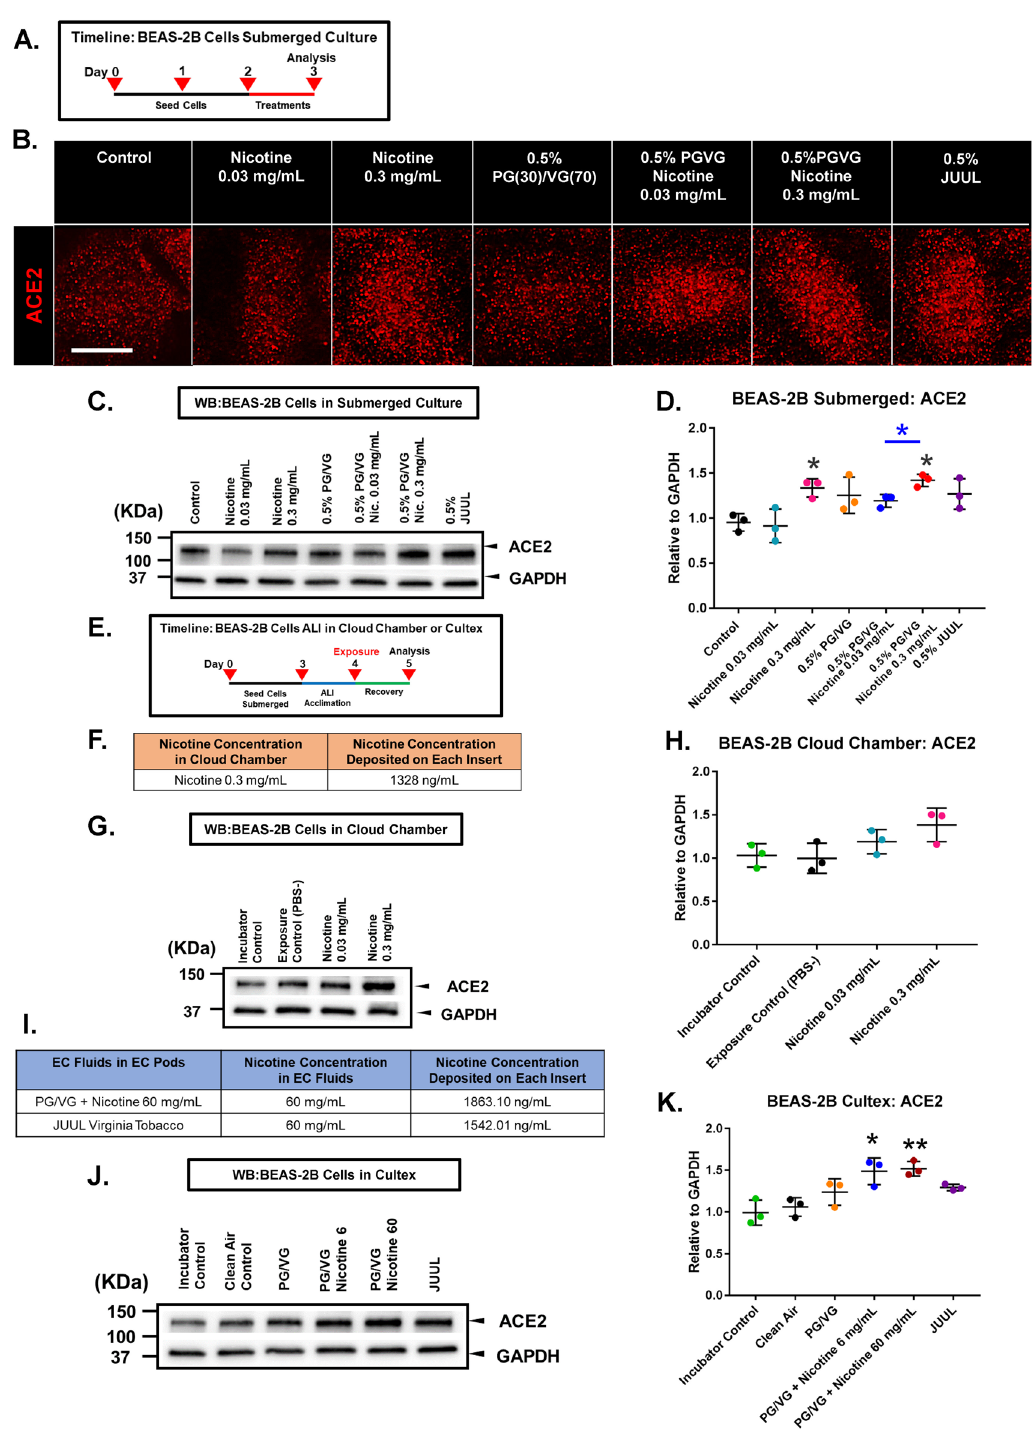
Figure 1. ACE2 expression in BEAS-2B cells during exposure in submerged culture and at the air–liquid interface. ( A ) Experimental treatment used in submerged culture. ( B ) Micrographs showing cells labeled with ACE2 antibody. Scale bar = 15 µm. ( C–D ) The effect of JUUL e-liquid, nicotine, and PG/VG on ACE2 during submerged culture (Western blot). ( E ) Experimental treatment used with cells exposed at the ALI in a cloud chamber or the Cultex system. ( F ) Concentration of nicotine deposited in each well following aerosolization of 0.3 mg/mL of nicotine in a cloud chamber. ( G – H ) The effect of 1 puff of nicotine-containing aerosol on ACE2 following ALI exposure in a cloud chamber (Western blot). ( I ) Nicotine concentration in each well following exposure to aerosol generated from PG/VG/nicotine 60 mg/mL or JUUL “Virginia Tobacco” in a Cultex system. ( J – K ) The effect of 10 puffs of nicotine- containing EC aerosols on ACE2 following ALI exposure in a Cultex system. The aerosols were generated from PG/VG, PG/VG with nicotine, and a JUUL EC. Data are plotted as the mean ± standard deviation of three independent experiments. Box-Cox transformed data were analyzed using a one-way ANOVA followed by Tukey’s test to compare means. Black * = significantly different than the control. Colored * and colored lines = significantly different groups. * p < 0.05, ** p < 0.01. Western blots were horizontally cropped from the original